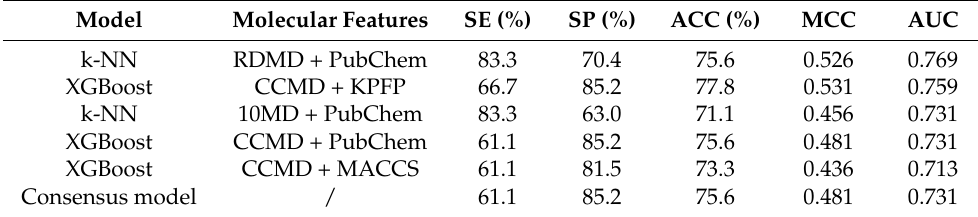
Table 4. Performances of the top-five classification models and consensus model on the external validation set.